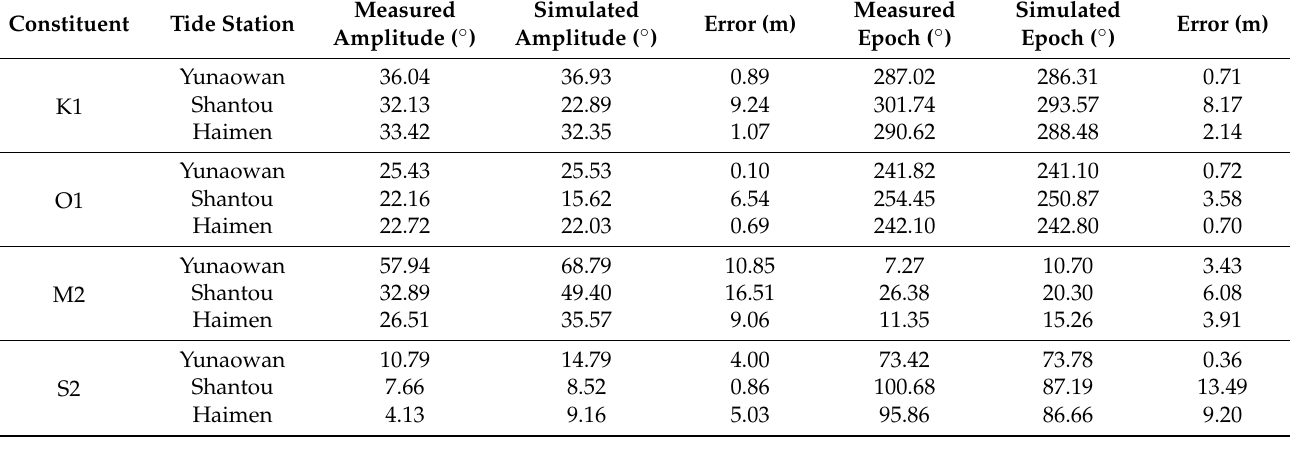
Table 1. Verification of tidal harmonic constant.